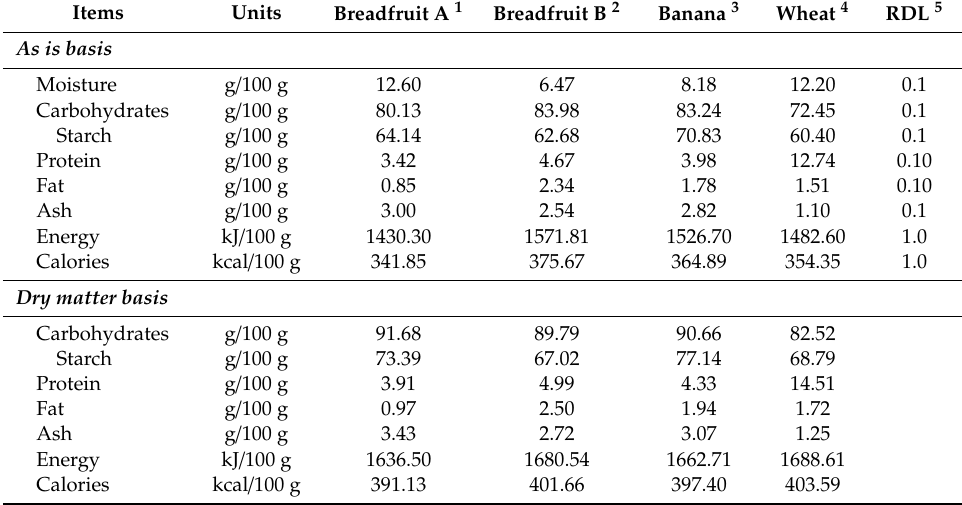
Table 1. Proximate composition of tropical flours compared with a traditional flour.